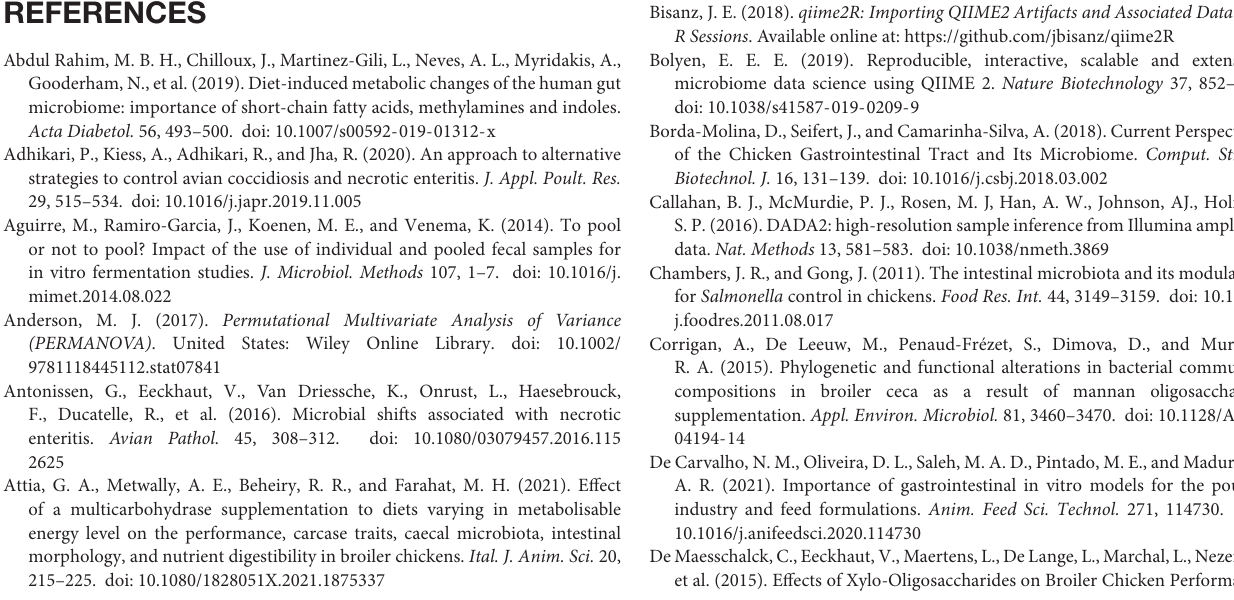
Supplementary Figure 1 | Flow chart of experimental set up of CALIMERO-2. (A) Experimental set up for the different sample types, SIEM, Modified SIEM-I and Modified SIEM-II. (B) The experimental set up over time. At the times indicated by ∗ samples were taken from both the lumen and dialysate. Supplementary Figure 2 | Bacterial alpha diversity. Data are presented as mean ( n = 2) ± sd. ( ∗∗ p < 0.001 and ∗∗∗ p < 0.0001) (A) . Inverse Simpson (B) . Gini-Simpsom (C) . Fisher (D) . coverage. Supplementary Table 1 | (1) Microbial feeding composition of SIEM, Modified SIEM-I and Modified SIEM-II. (2) Significant difference between bacterial phyla between groups. (3) Significant difference between bacterial families between